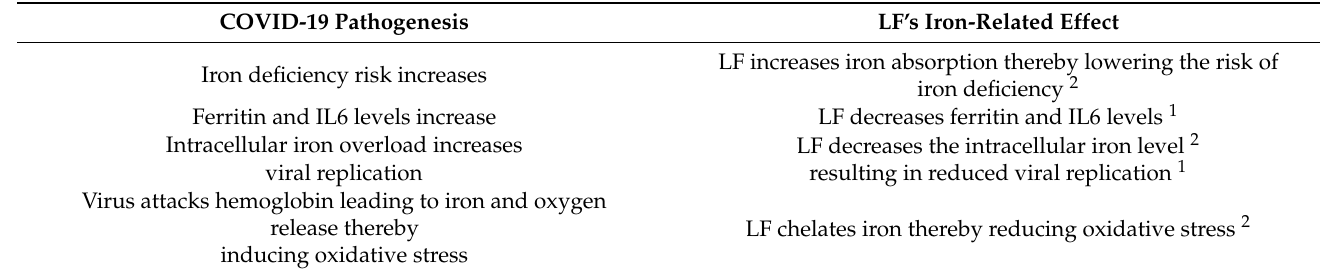
Table 1. Physiological effects as part of COVID-19 pathogenesis (left column) and counteracting iron- related effects of LF clinically demonstrated in COVID-19 patients or other populations (right